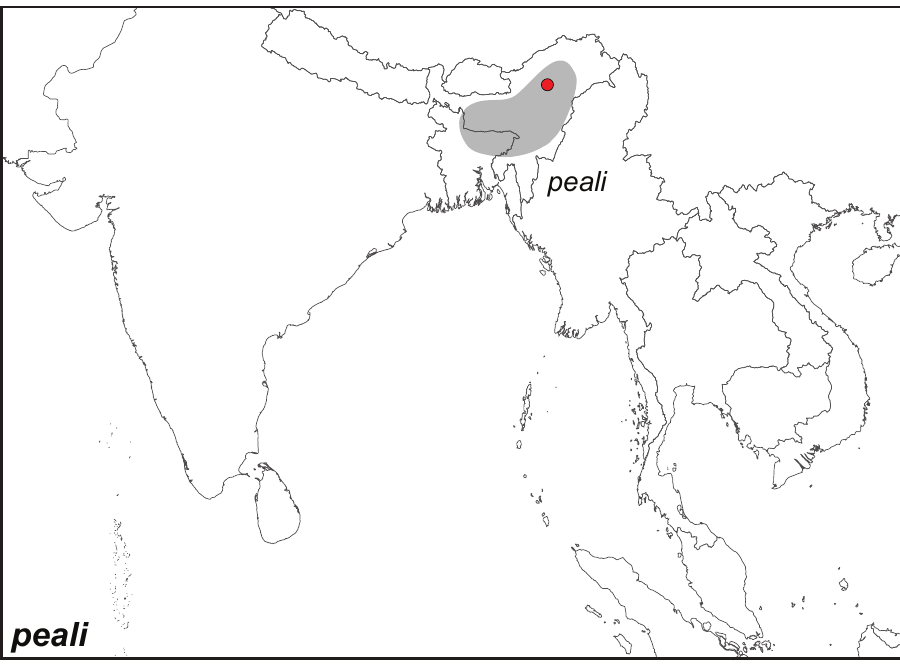
Figure 34. Distribution map of Elymnias peali